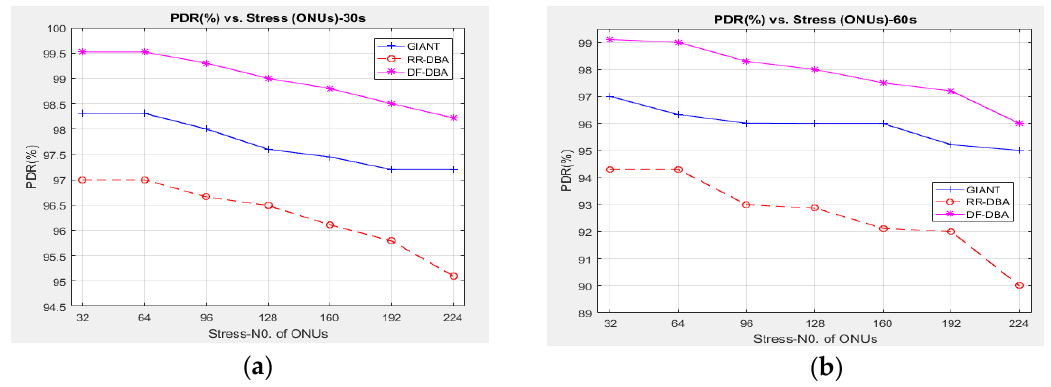
Figure 6. PDR (%) Analysis. ( a ) PDR (%) vs. Stress (ONUs) -30s ( b ) PDR (%) vs. Stress (ONUs) -60s.